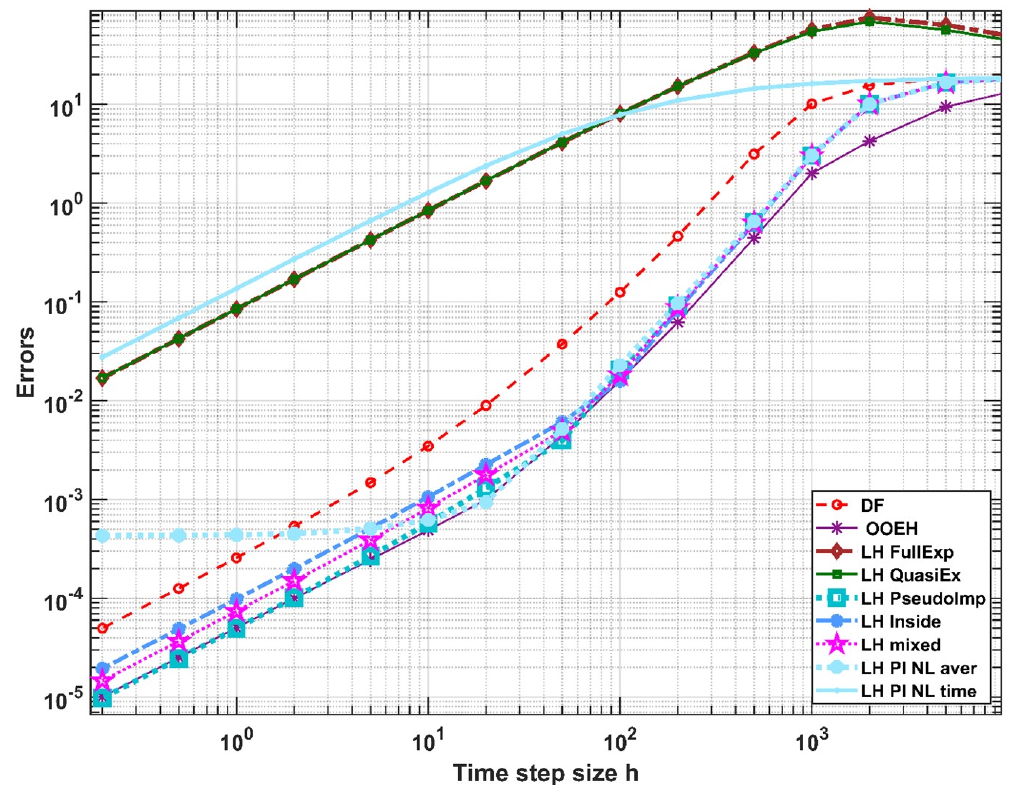
Figure 13. The maximum errors as a function of the time step size for the nine examined methods in the case of a surface area (Experiment 6). We emphasize that the different treatments now refer to the radiation term.